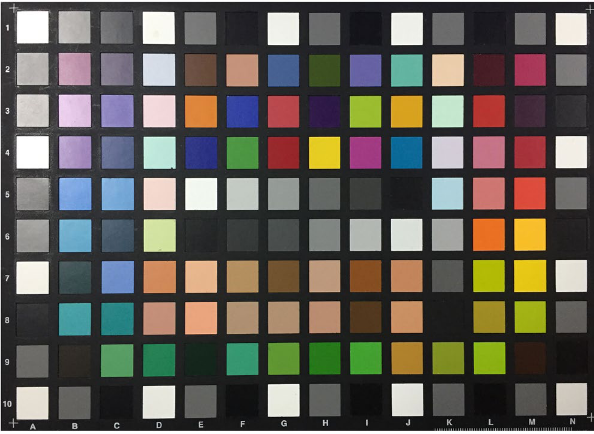
Figure 2. Conventional colour chart used for colour profile